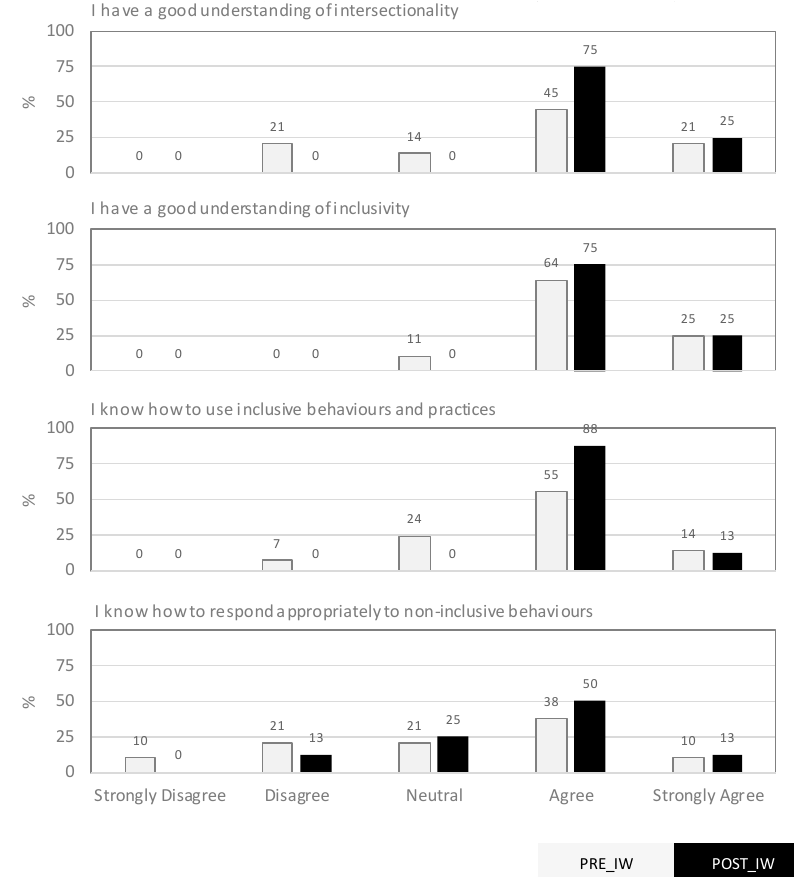
Figure 2. Intersectionality Walk participant survey responses as individuals, before and after the IW. Survey responses are shown as % positive responses for each category. PRE_IW denotes before the IW (N = 29), POST_IW denotes after the IW (N =